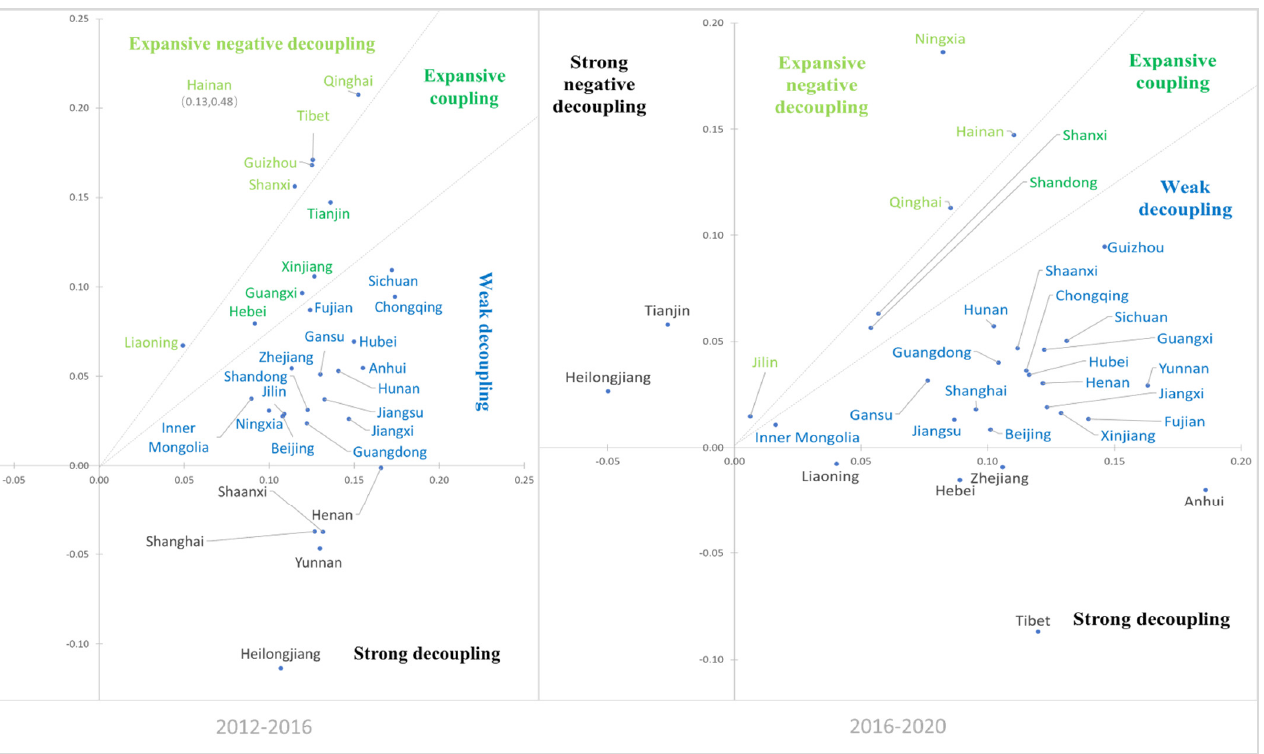
Figure 17. Analysis of decoupling type of added value of service-industry.